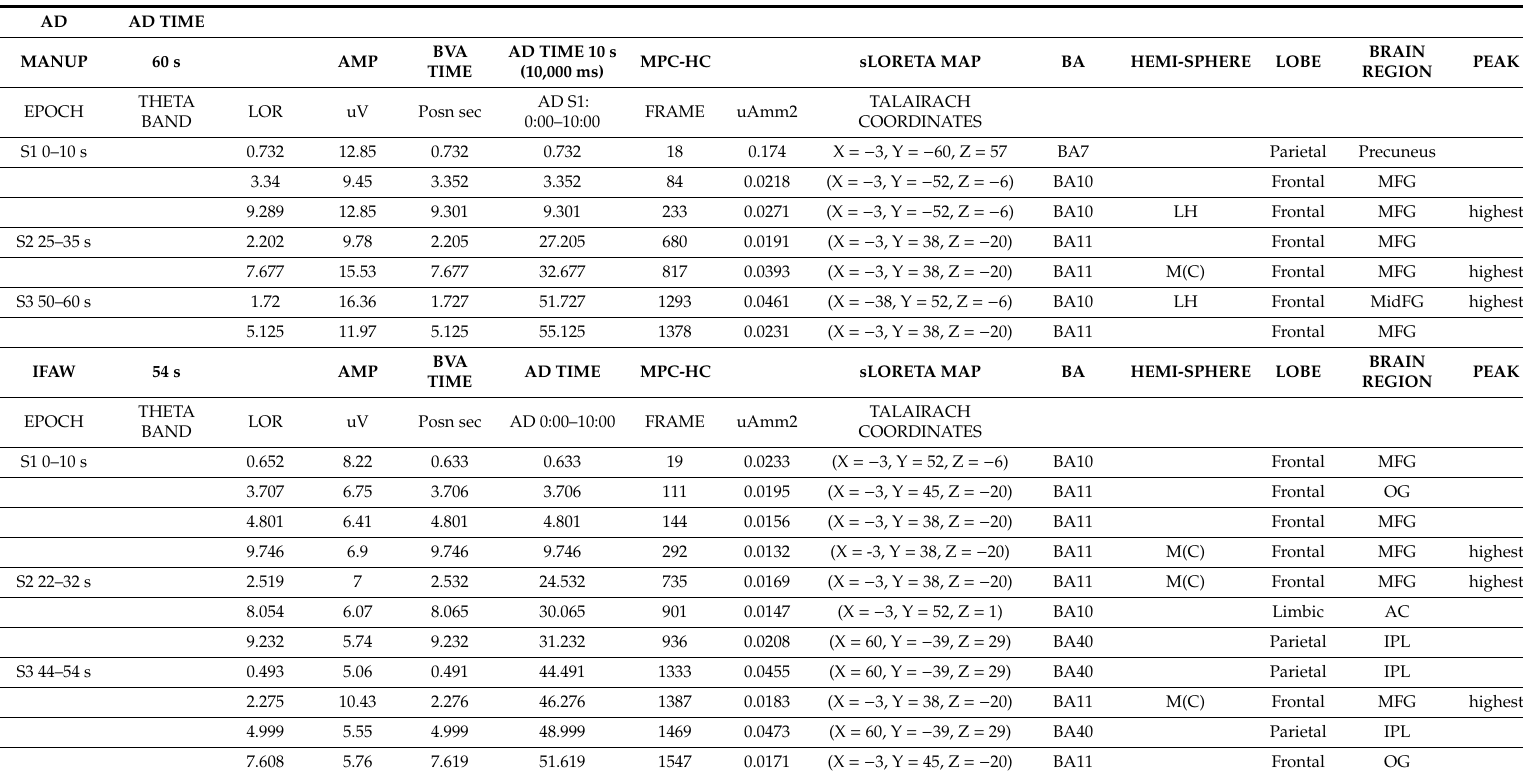
Table A1. IFAW, Agilis three highest theta amplitudes from the first, middle, and final 10-s epochs (includes BVA times, ad times, and Brodmann areas (BA)) used for ad images of peak theta averages shown in Figures 2–5 and Table 2; Table